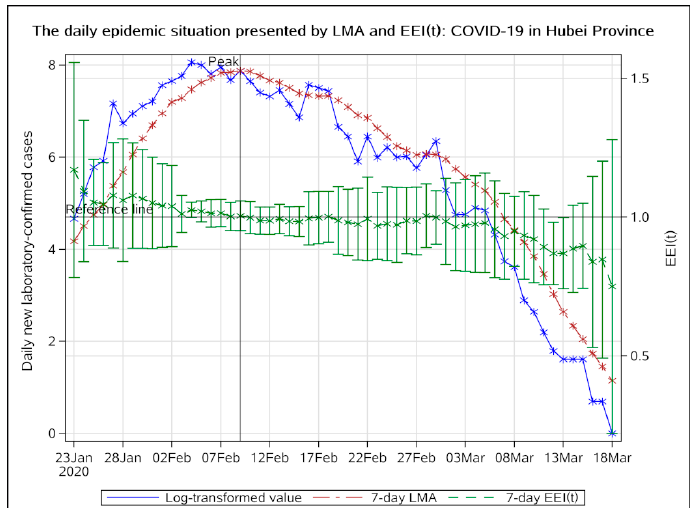
Figure 2. The daily epidemic situation presented by LMA and EEI(t), COVID-19 in Hubei Province, from 23 January to 18 March 2020. The blue line indicates the change of the log-transformed value over date. The brown line indicates the change of 7-day LMA over date. The green line indicates the change of the EEI(t) over date. LMA, moving average of log-transformed daily new cases and EEI(t), epidemic evaluation index (t).